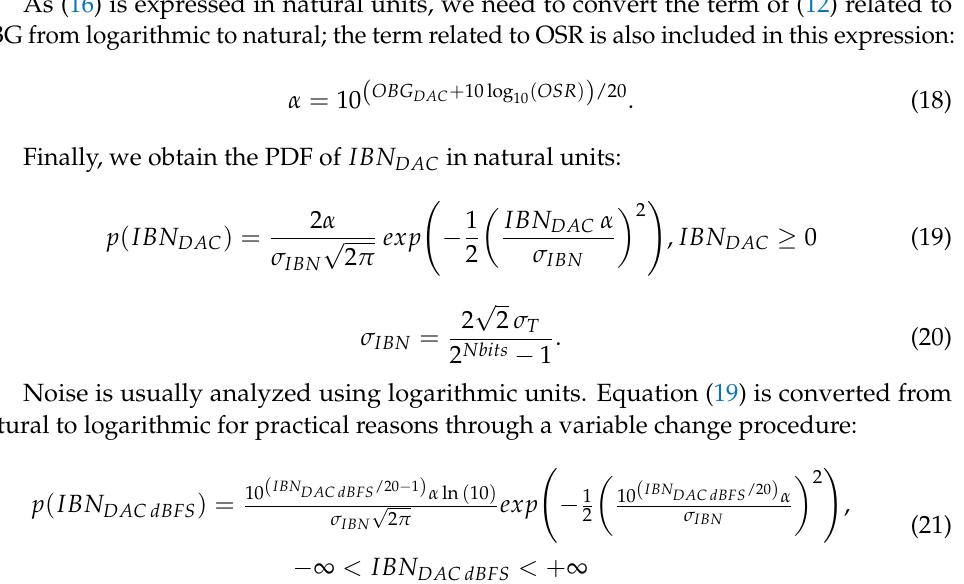
Figure 11. ( a ) IBN DAC dependence on OSR and OBG; | DAC (cid:48)(cid:48) on OBG ( OSR = 64). ( c ) IBN DAC dependence on OSR ( OBG =